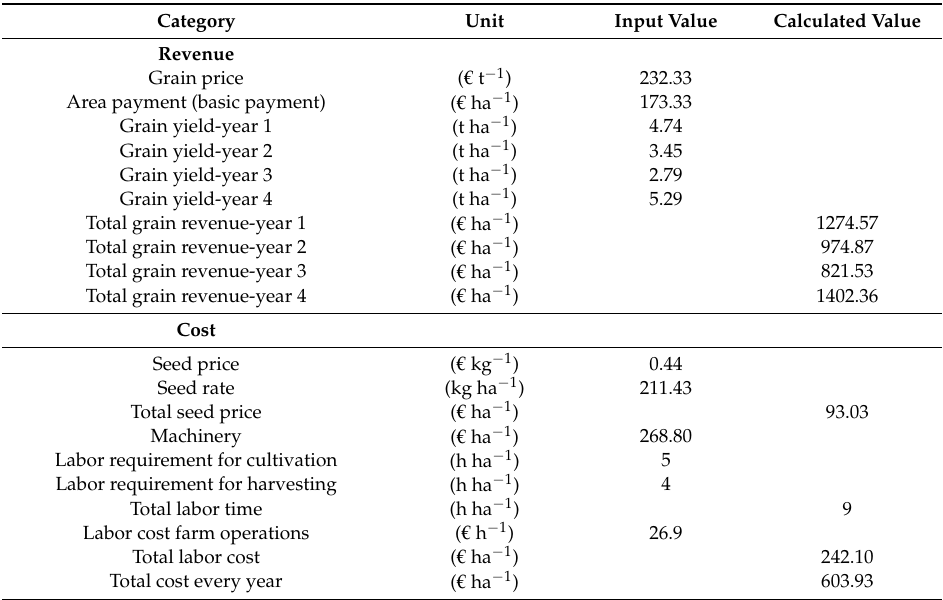
four-year period.